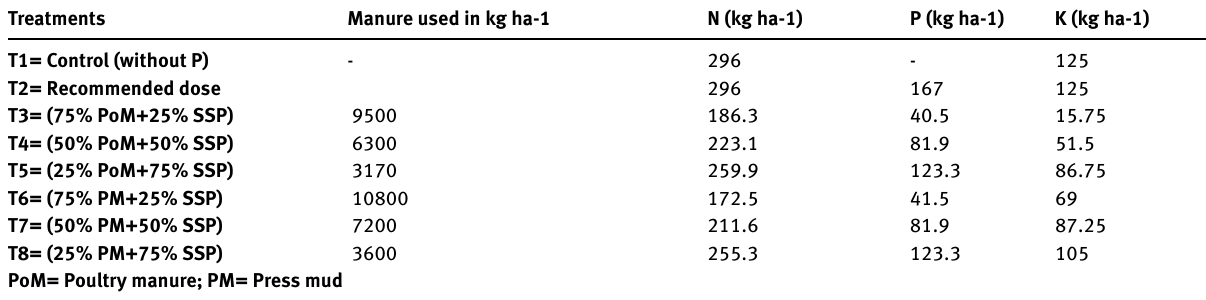
Table 2: Nutrient contents applied during the study through different organic and inorganic sources Treatments Manure used in kg